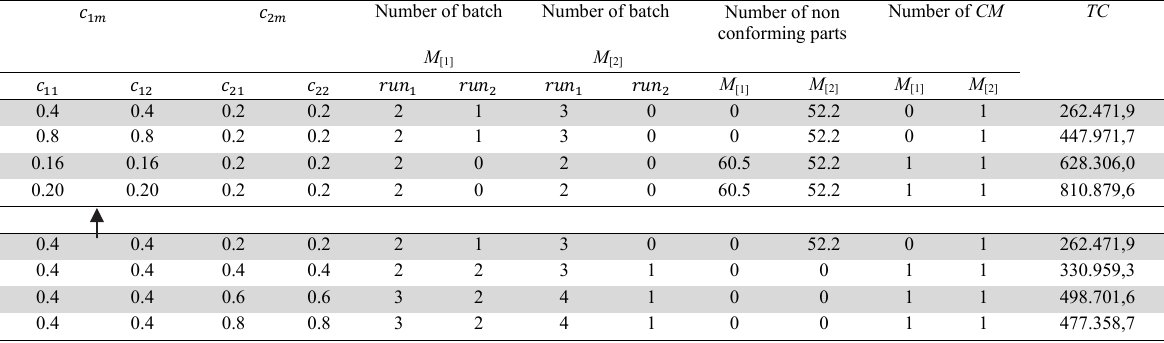
Parameter sensitivity analysis for Model